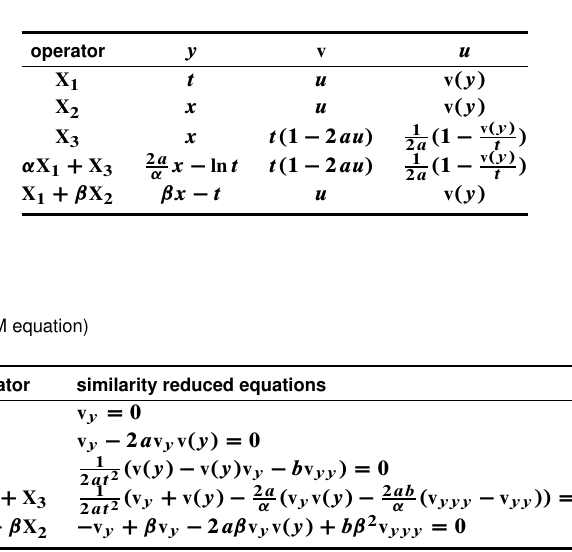
Table 5. Reduction of BBM equation